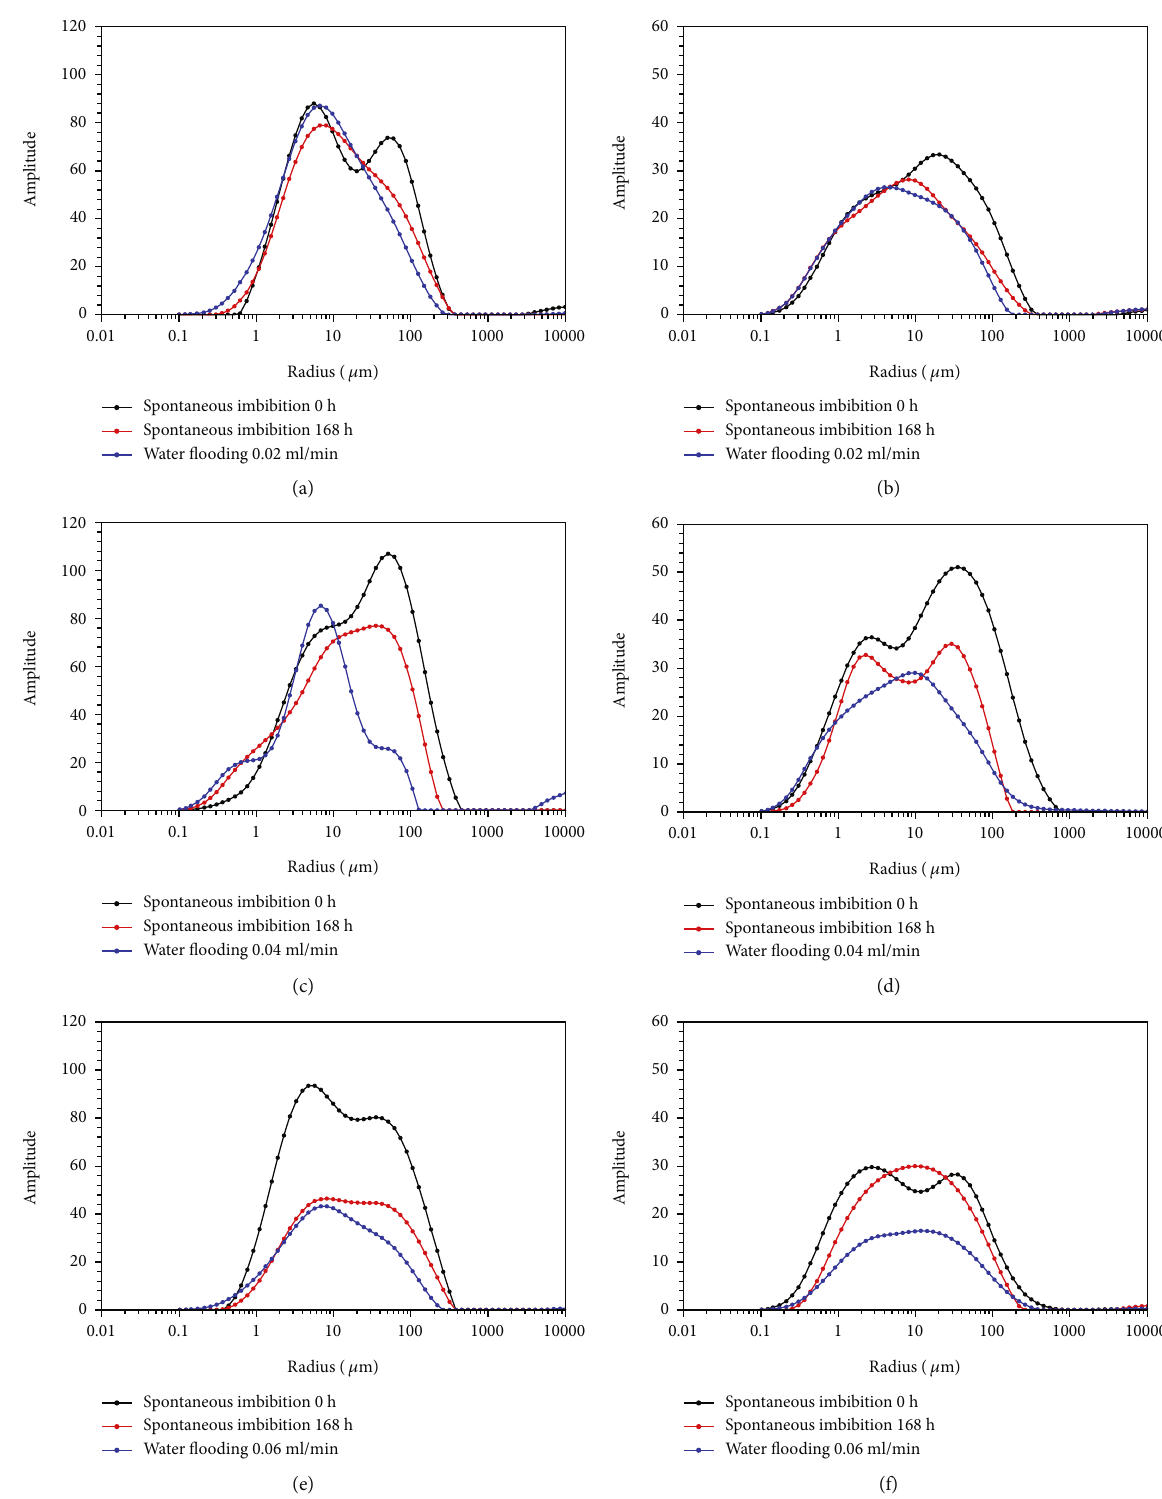
Figure 4: Nuclear magnetic resonance T spectrum curves. (a) Spontaneous imbibition 168h and 0.02mL/min displacement T 2 spectrum (core 3-2); (c) spontaneous imbibition 168h and (core 3-1); (b) spontaneous imbibition 168h and 0.02mL/min displacement T 2 spectrum (core 3-1); (d) spontaneous imbibition 168 h and 0.04mL/min displacement T 0.04mL/min displacement T 2 spectrum (core 3-1); (f) spontaneous imbibition 168h and 0.06mL/min (e) spontaneous imbibition 168 h and 0.06mL/min displacement T 2 spectrum (core displacement T 2